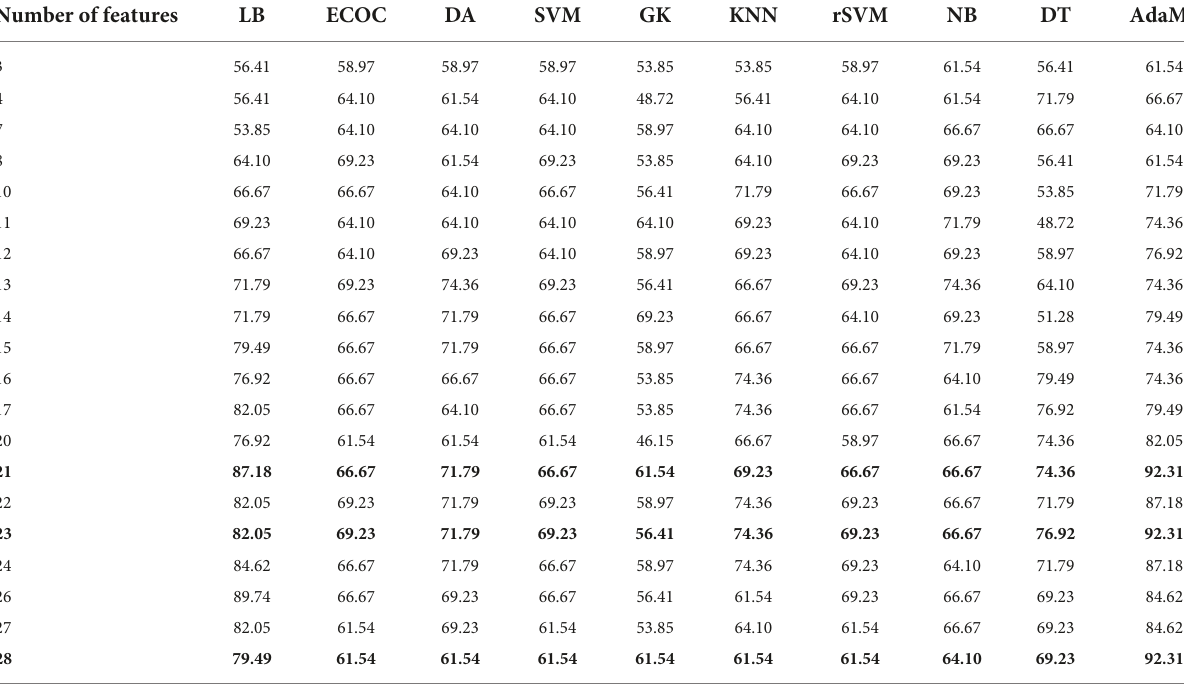
TABLE 3 Comparison of each model performance according to number of final features. Number of features